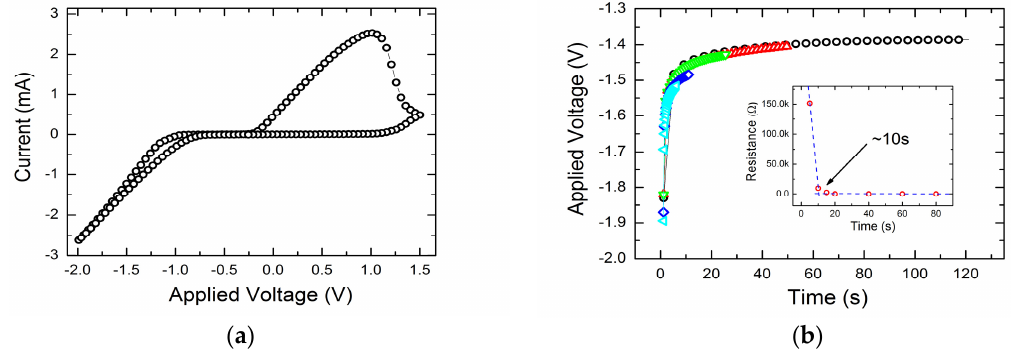
Figure 2. ( a ) Cyclic voltammogram trace for Permalloy on highly resistive n ‐ type silicon and ( b ) Galvanostatic deposition transient for different deposition times. The extrapolation of resistances obtained from the IxV curves as a function of the deposition time (see inset of ( b )), provides the estimated percolation time of 10 s.